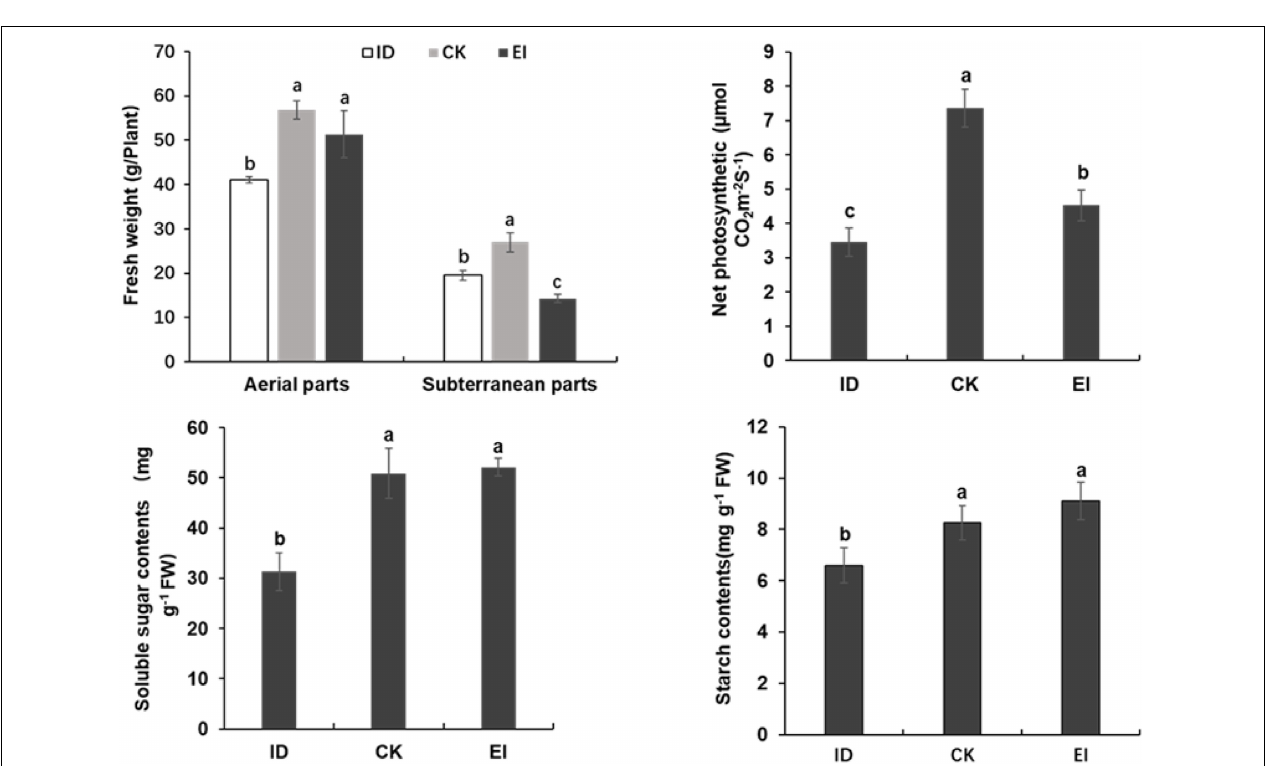
FIGURE 3 | Fresh weight, photosynthetic efficiency and carbon hydrate in ID, CK and EI leaves. The small bars show standard deviation. Different letters represent significant differences at P < 0.05 according to Duncan’s multiple range tests.